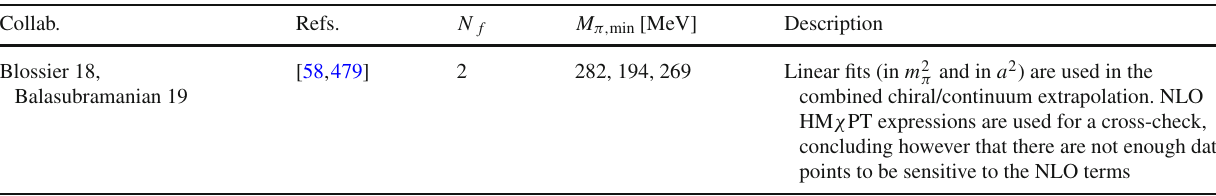
Table 126 Chiral extrapolation/minimum pion mass in N f = 2 determinations of the D - and D s -meson decay constants. For actions with multiple species of pions, masses quoted are the RMS pion masses. The different M π, min entries correspond to the different lattice spacings Collab.